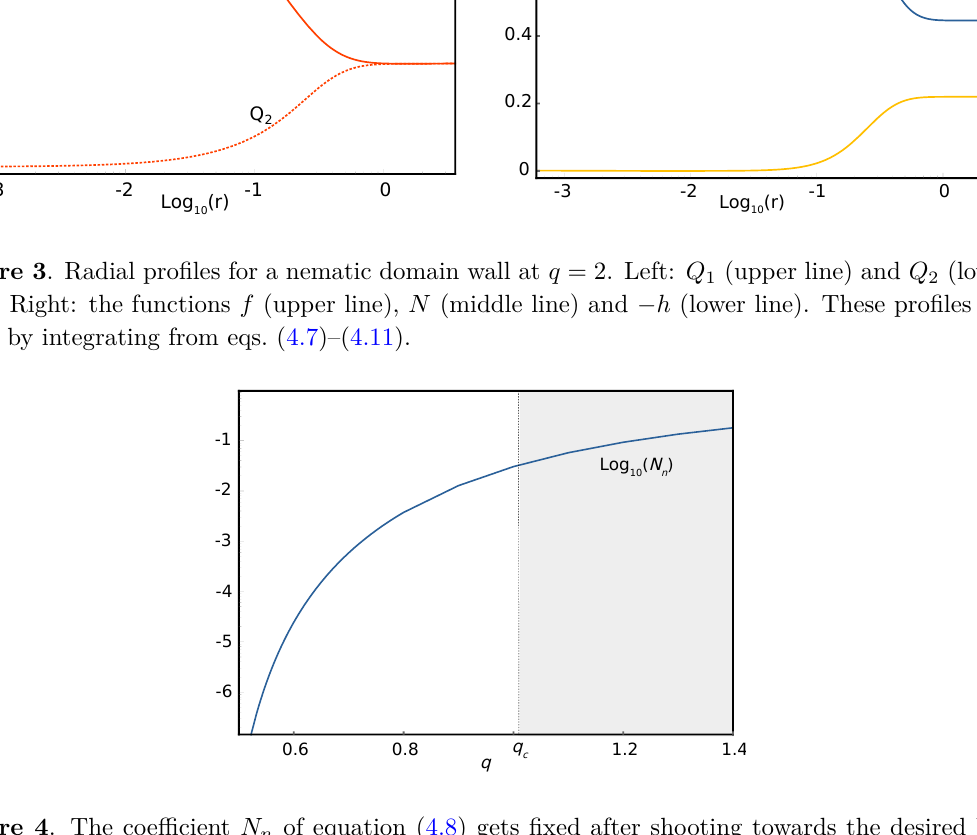
Figure 4 . The coefficient N n of equation (4.8) gets fixed after shooting towards the desired UV boundary conditions (3.5). We plot its value as a function of the backreaction parameter q to see that solutions still exist below q c , but the numerical value of N n becomes highly